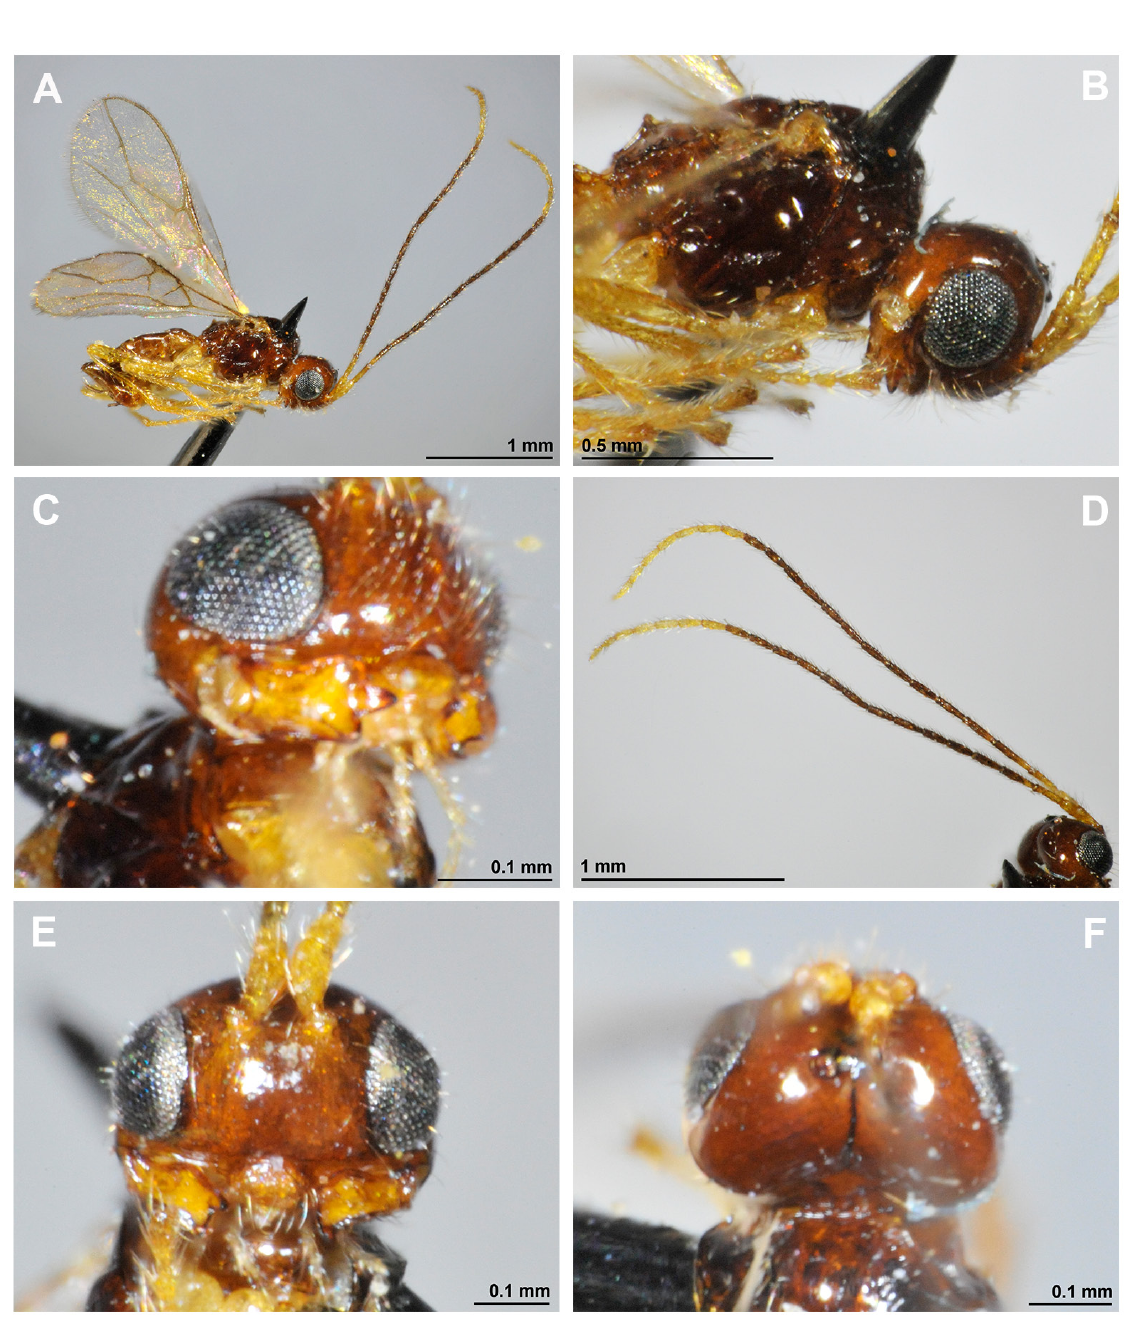
Fig. 60. Asobara subdentata (Granger, 1949), ♀, holotype (MNHN). A . Habitus, lateral view. B . Head and mesosoma, lateral view. C . Mandible. D . Antenna. E . Head, front view. F . Head, dorsal